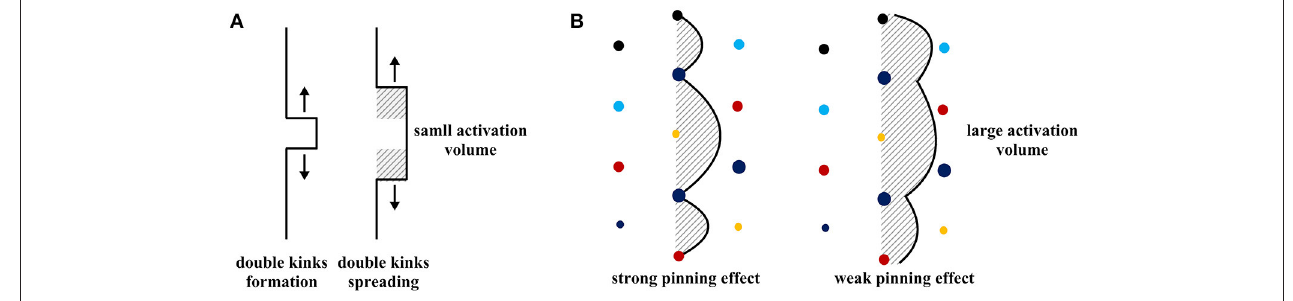
FIGURE 8 | (A) Dislocation gliding via kink-pair mechanisms in an ideal lattice. (B) Wavy dislocation gliding in a distorted lattice in chemical complex